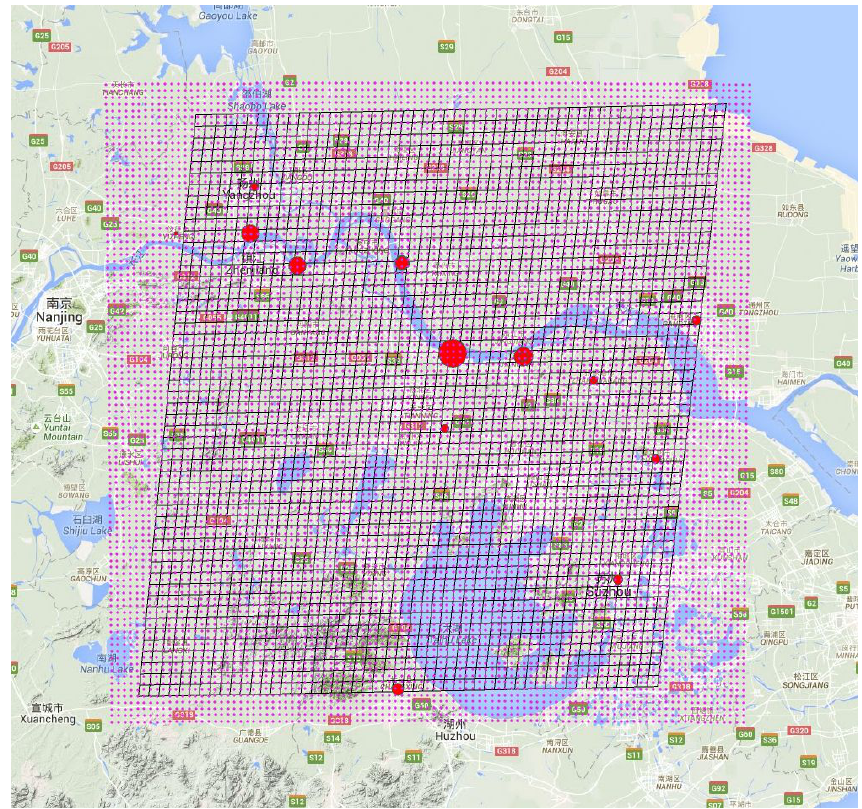
Figure 1. Target area around Shanghai showing the geoCARB footprints (skewed grid) and the centres of the Weather Research and Forecasting model cells (small red dots). The large red dots indicate power plants as listed by CARMA (Carbon Monitoring for Action, http://carma.org), with the sizes of the dots proportional to the annual CO 2 emissions from the plants. The distance from the south-western to the south-eastern corner of the geoCARB grid is approximately 158km, while from the south-eastern to the north-eastern corner it is approximately